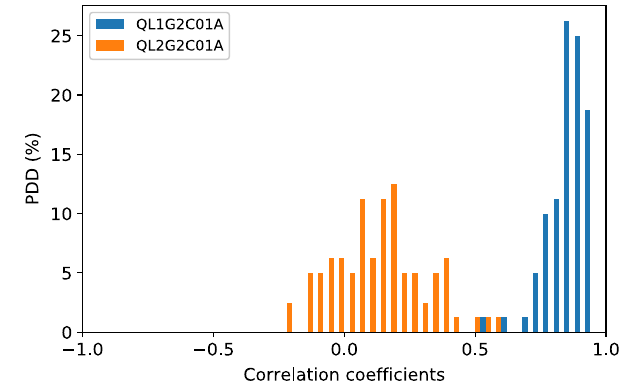
FIG. 5. The probability density distribution (PDD) of the correlation coefficients between 800 measured β x distortion and two unit vectors v 10 ; 11 . The independently and repeatedly measured β -beats are highly correlated with quadrupole 10 ’ s pattern, rather than its neighbor. Based on that we can conclude that the actual error source is more likely from the quadrupole 10 ( QL1G2C01A ) instead of quadrupole 11 ( QL2G2C01A